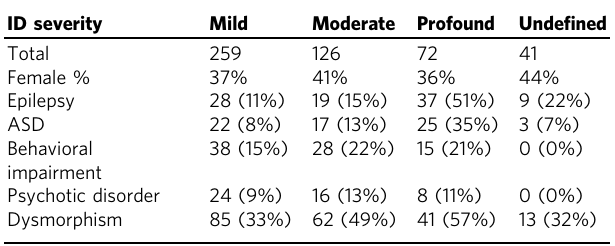
Table 1 Patient clinical characteristics in the NFID sample